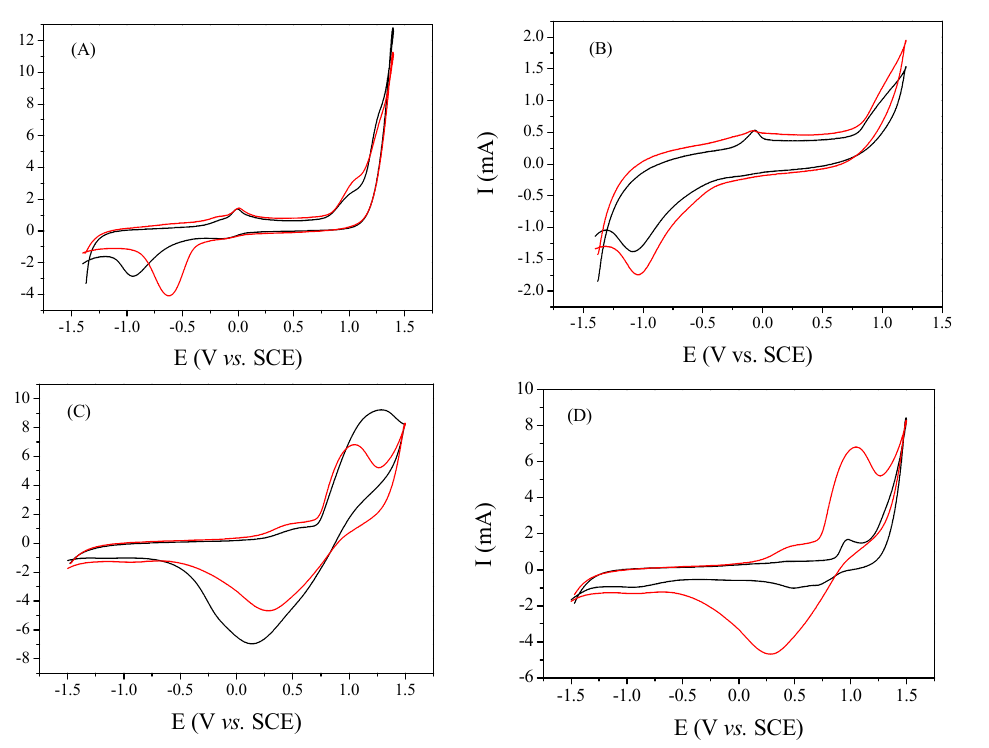
Figure 10. Cyclic voltammograms of FeCu-NaY-CT ( A ), CuFe-NaY-CT ( B ), FeMn-NaY-CT ( C ) and MnFe-NaY-CT ( D ), with a scan rate 0.05 Vs − 1 in a different potential range in 0.10 M NaCl (------) with PY (------, 30 ppm).